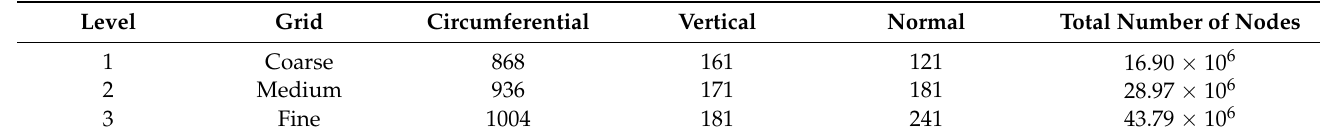
Table 1. Grid sizes.